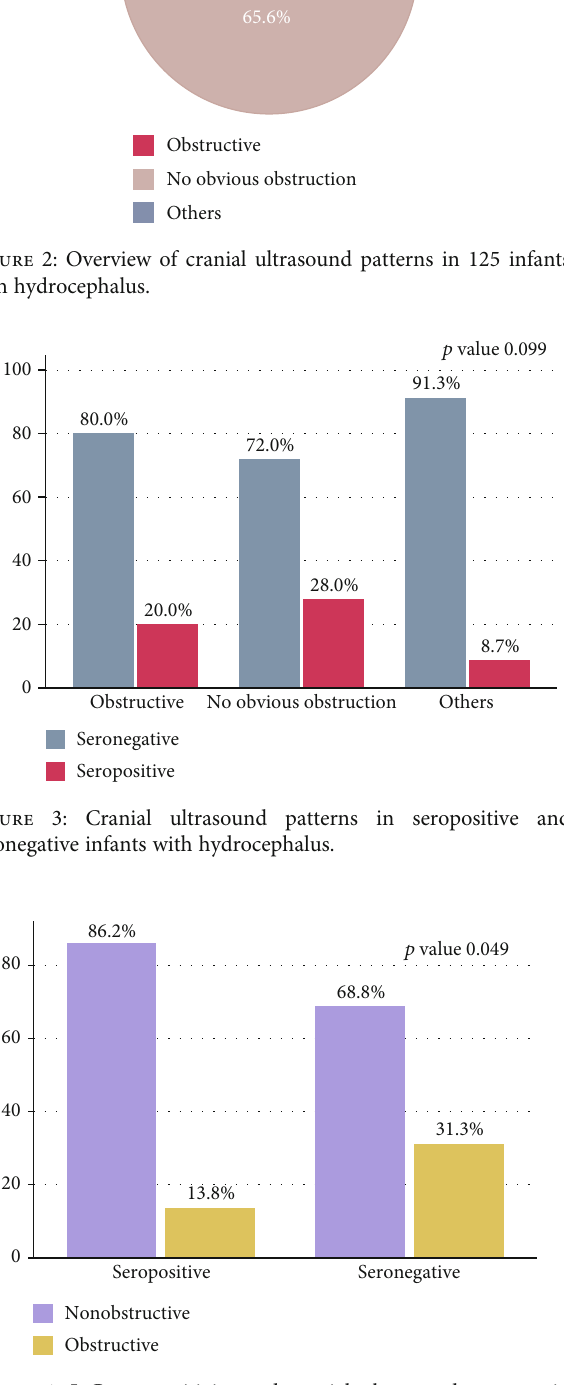
Figure 4: IgG seropositivity and cranial ultrasound patterns in infants with